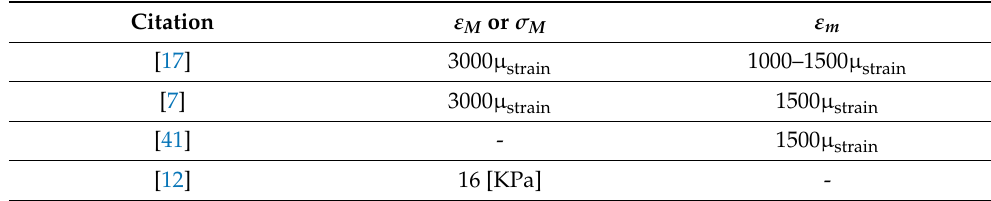
Table 2. Acceptable PDL range of strains or stresses in OTM. The maximal strains or stresses in the remodeling stage are denoted by ε M or σ M . Beyond these values, significant pathological biological processes may occur. These may require adjustments in the model, which is beyond the scope of this research. The minimal strain ε m required for the remodeling process to take place is considered in the proposed model.